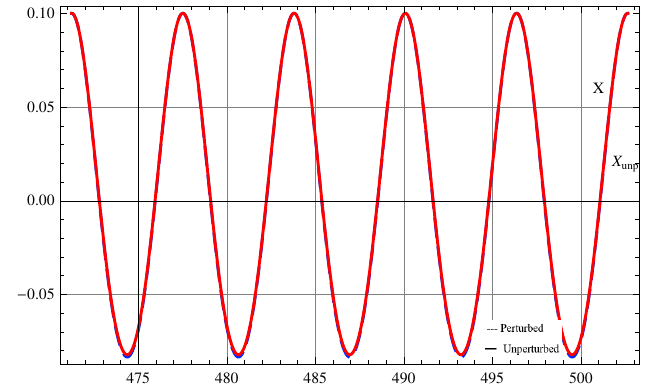
Fig. 2 Perturbed and unperturbed x-component of the deputy relative position with the Chief true anomaly.